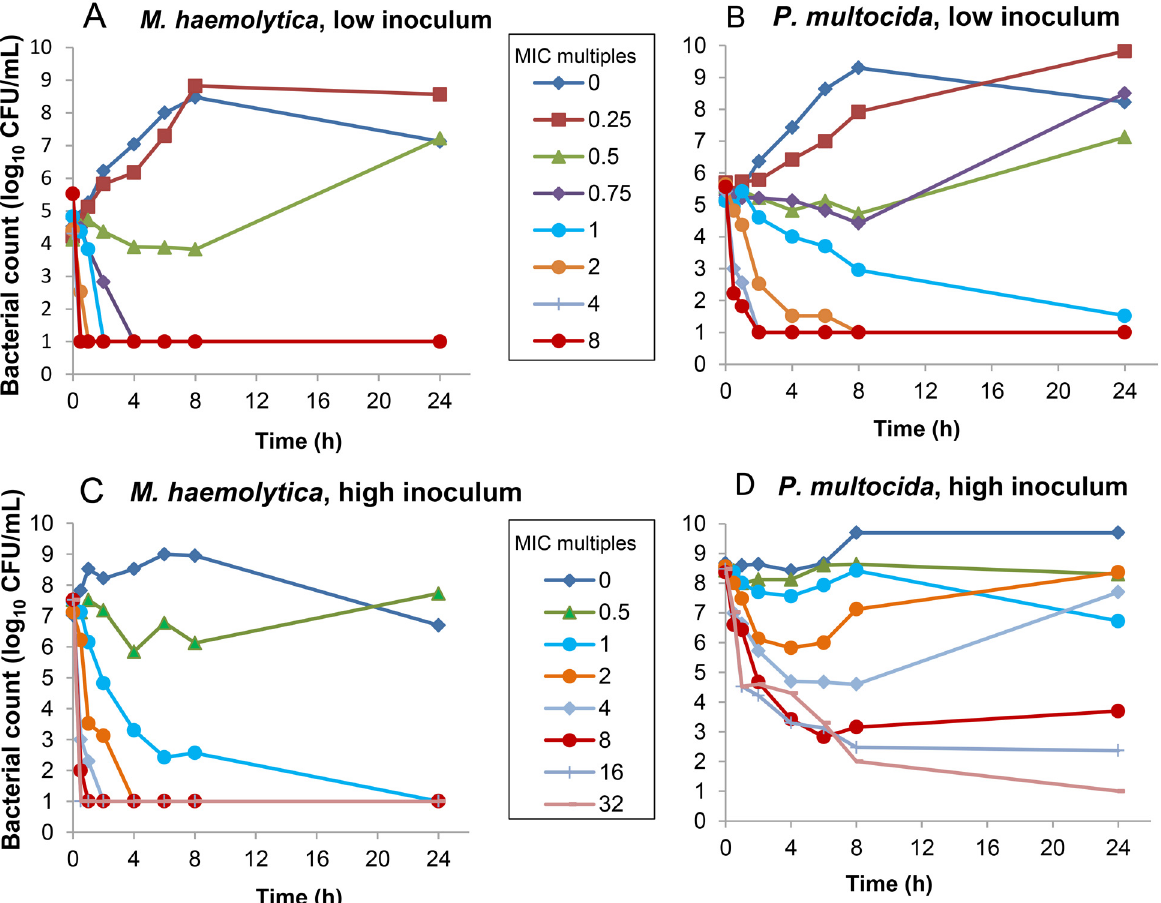
Fig 1. Time-kill curves of low (10 5 CFU/mL) (A and B) and high (10 8 CFU/mL) (C and D) inocula of M . haemolytica (A and C) and for P . multocida (B and D) in the presence of marbofloxacin (concentrations shown in multiple of the MIC (MIC = 0.016 μ g/mL for P multocida and MIC = 0.03 μ g/mL for M . haemolytica